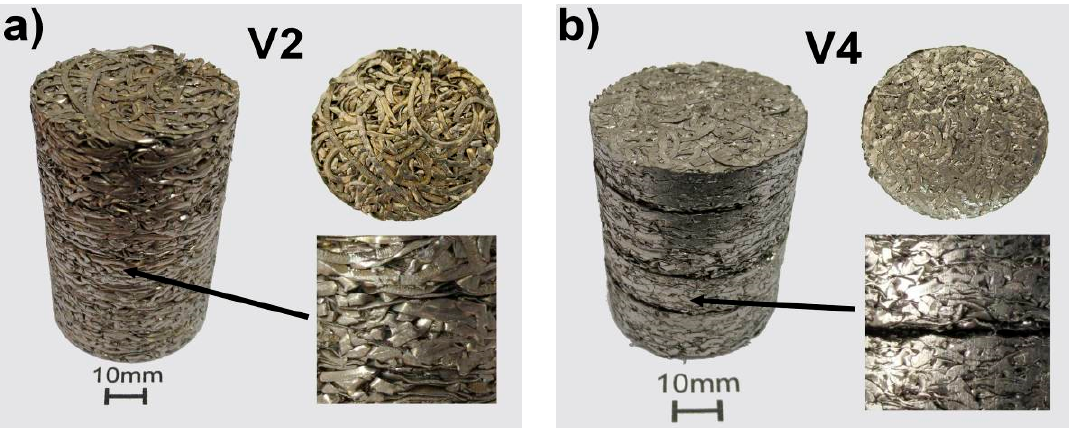
Figure 4. Sample views of titanium Gr4 briquettes obtained by preliminary consolidation: ( a ) briquette consisting of coarse chips after turning—variant V2, ( b ) briquette consisting of coarse chips after milling—variant V4.